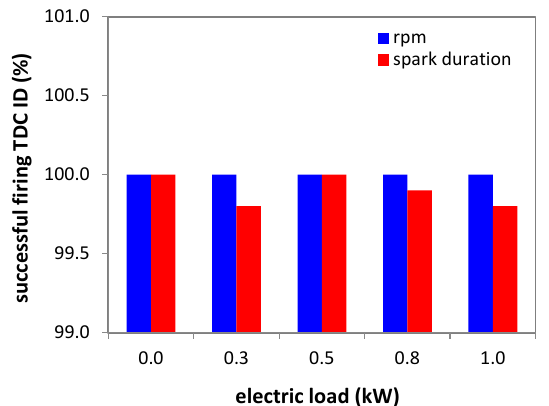
Figure 10. Success rate of firing TDC identification for the rpm and spark duration methods in odd/even mode.